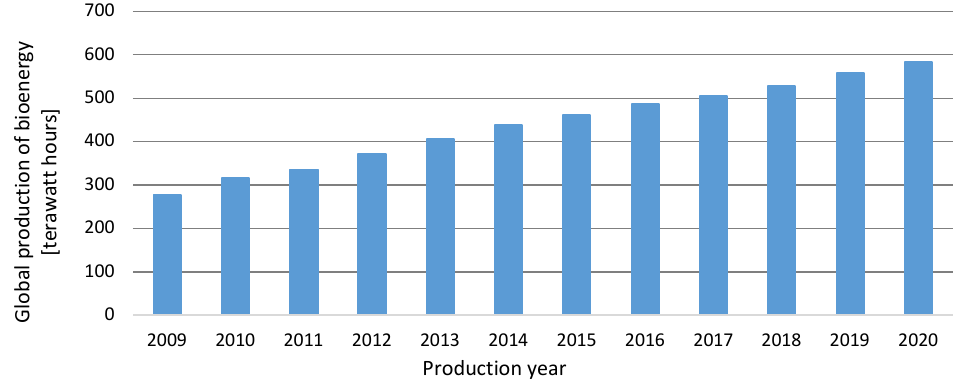
Figure 5. Global production of bioenergy (2009–2020) [28].